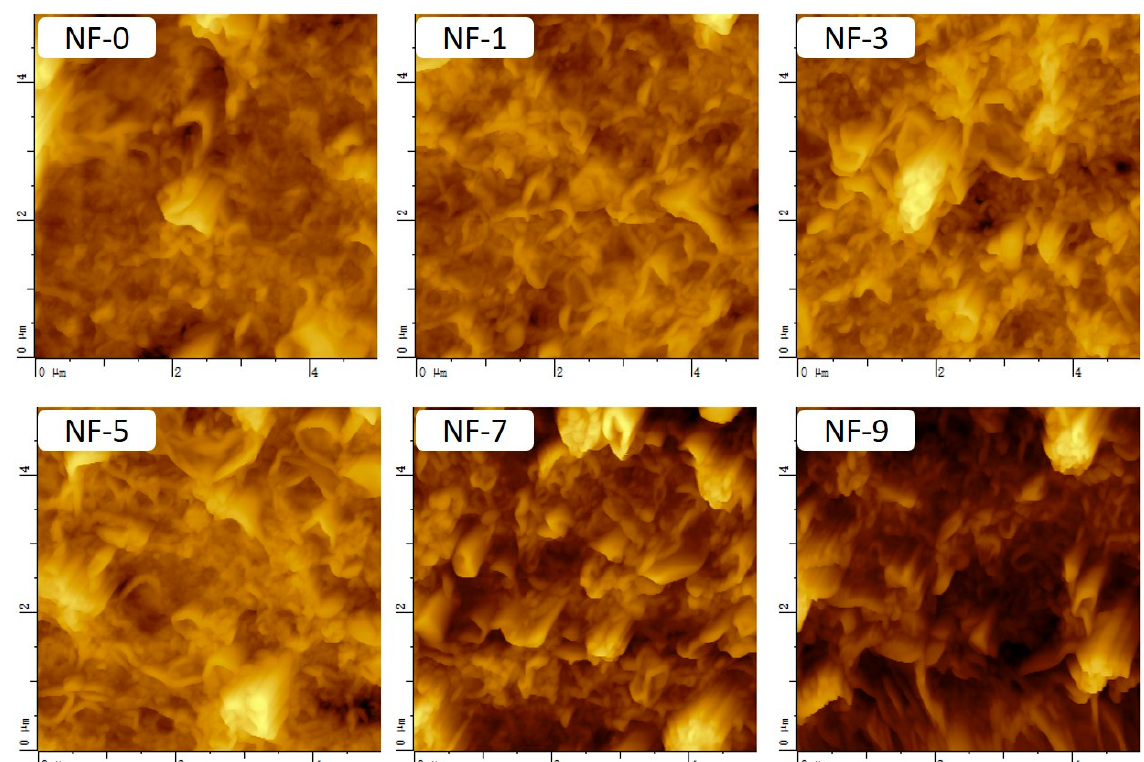
Figure 6. AFM of NF membranes prepared with different DWCNT dosages. Table 1. Surface parameters of NF membranes with different DWCNT dosages. Specific Surface Area